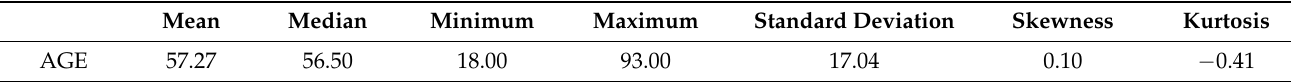
Table 1. Basic descriptive statistics on the age of injured people.